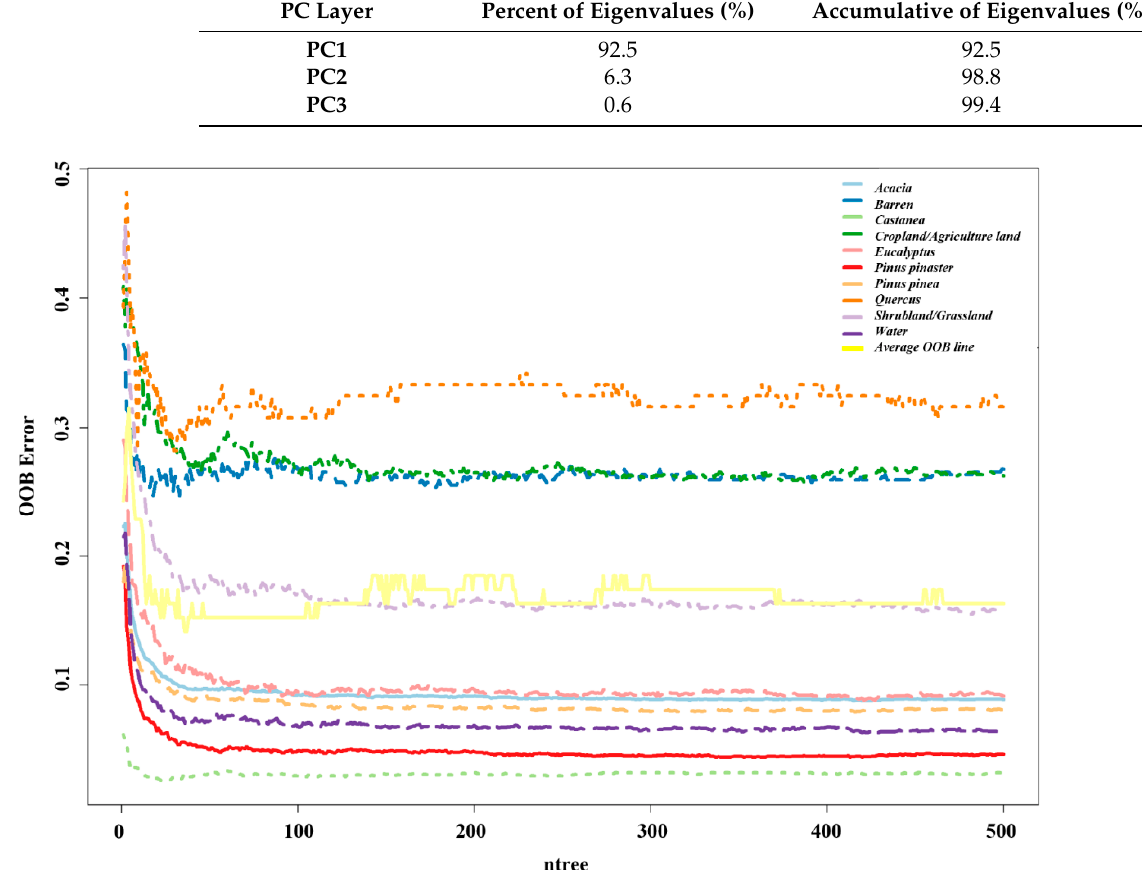
Figure A2. OOB Error of the number of RF mtry. Appendix B Table A2. Classification result represented in the area (ha) and percentage. Class ID